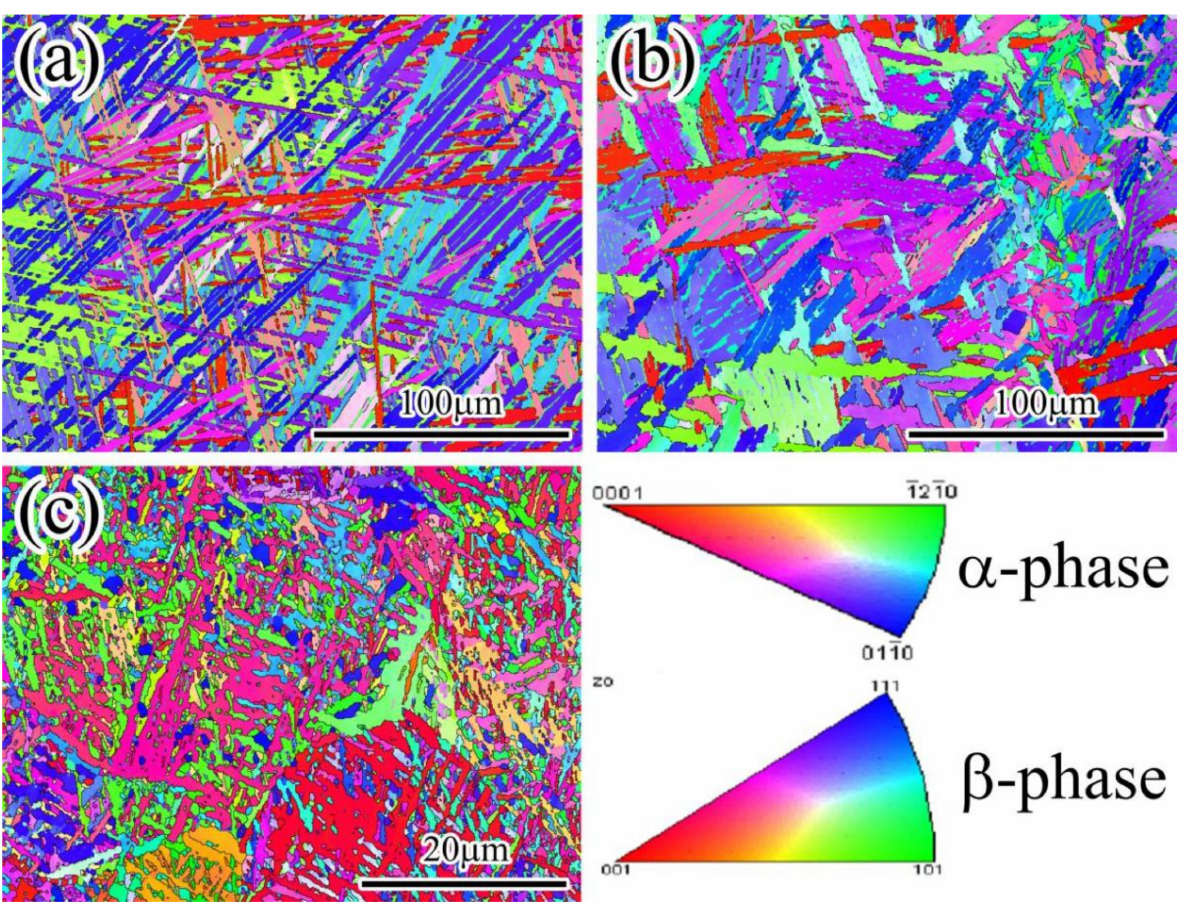
Figure 5. EBSD micrographs of different zones of the IFW joint ( a ) BM; ( b ) TMAZ; ( c )